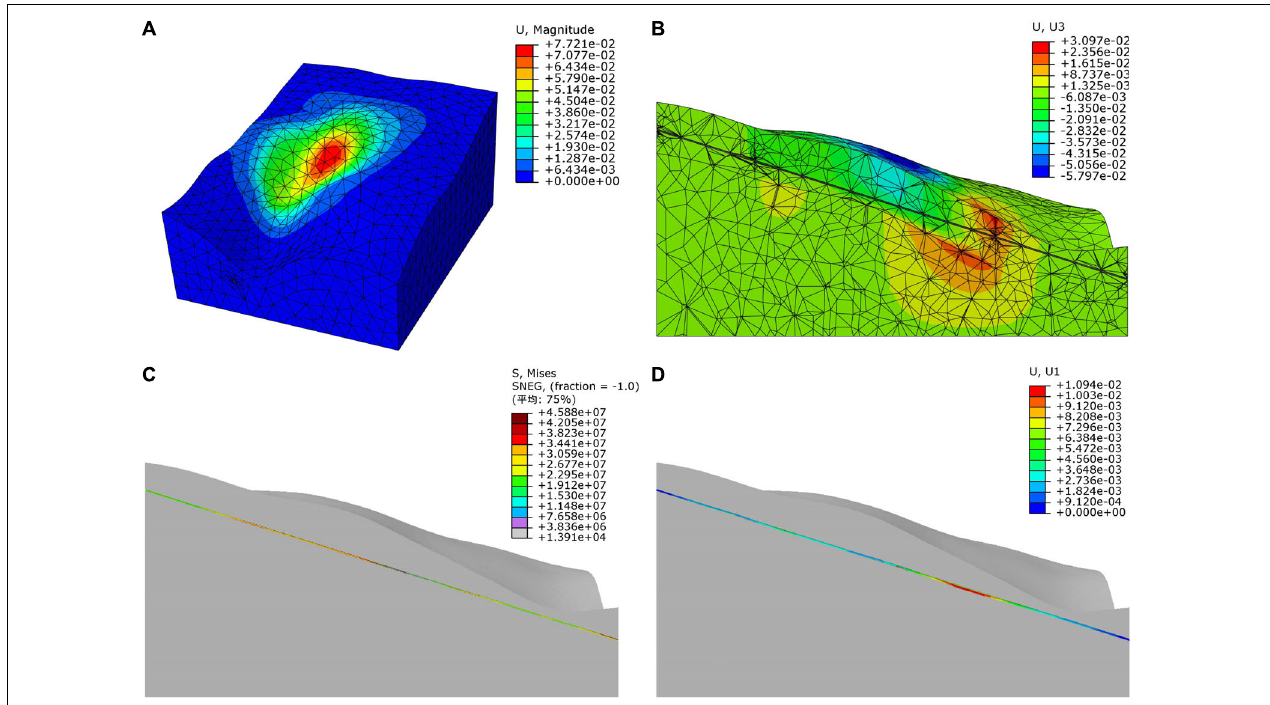
FIGURE 11 | Slope displacement, pipeline Mises’s stress, and pipeline displacement in a small sliding state. (A) Slope displacement, (B) Slope vertical displacement along the pipe section, (C) Pipe Mises stress, and (D) Along an unstable slope deformation of the pipe in the direction of movement ( x